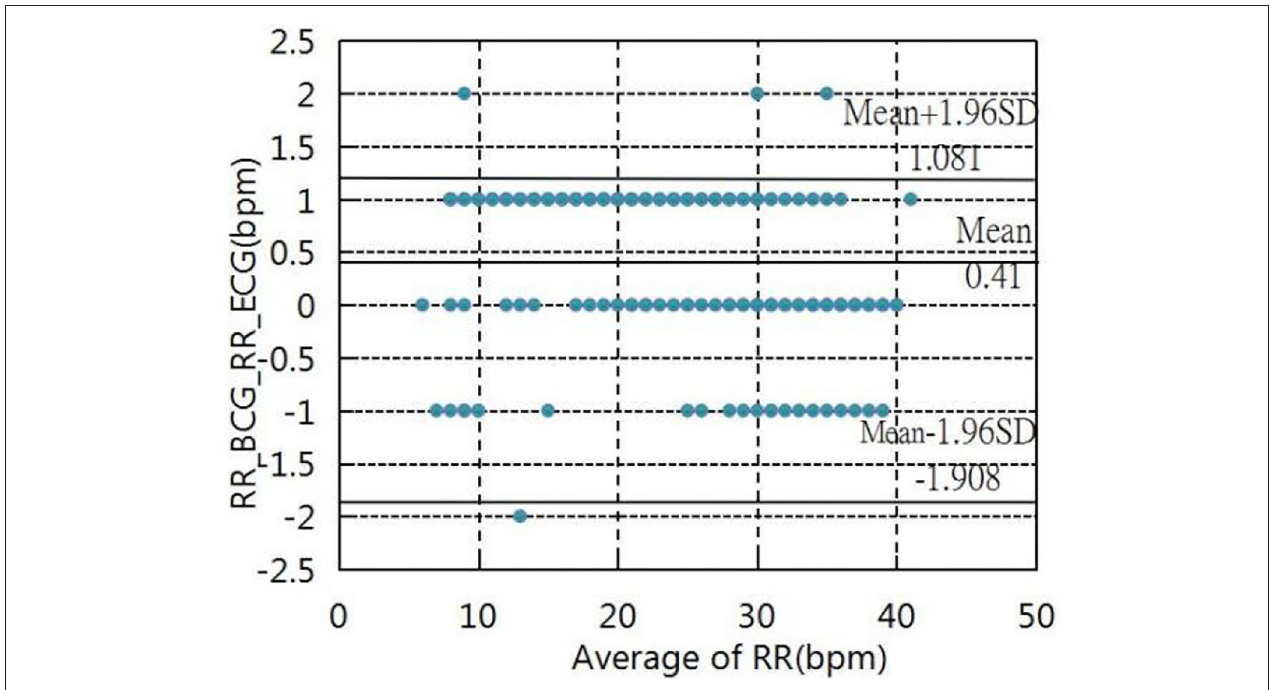
FIGURE 18 | Bland–Altman plot of respiration